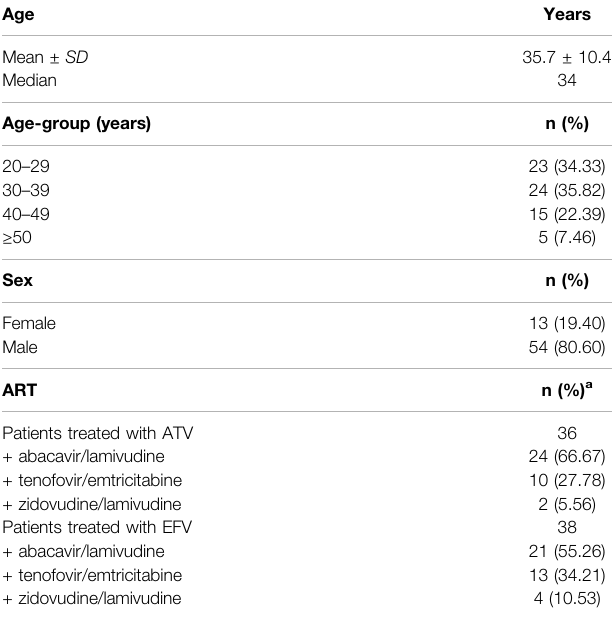
TABLE 1 | Baseline characteristics of the patients ( n (cid:1)